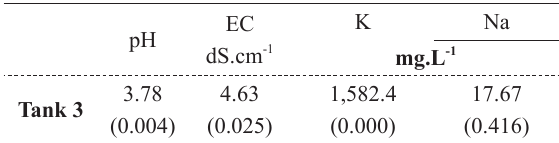
ADSORPTION ISOTHERMS FOR POTASSIUM IN THE SOIL Vinasse